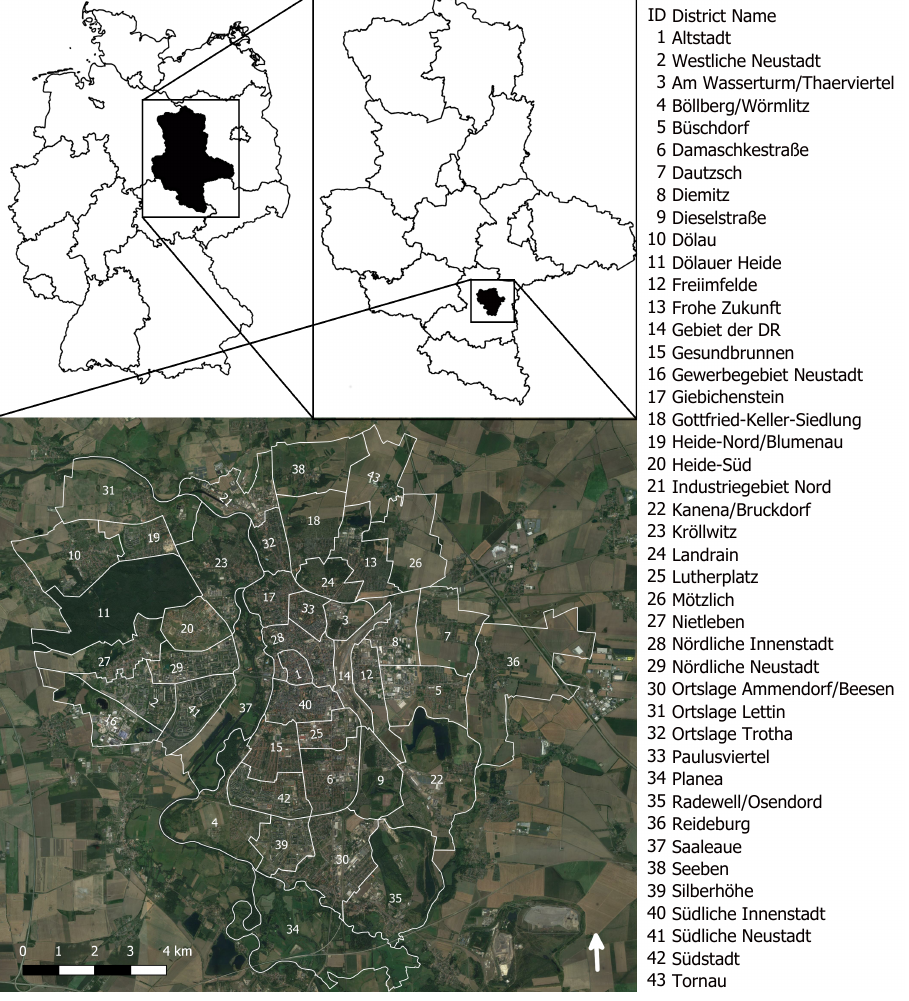
Figure 1. Map of the city of Halle with district names (in the geographical information system software QGIS, version 2.18; Google Maps 2018; German Federal Agency for Cartography and Geodesy—BKG 2018 [27]). Halle is located in the Federal State Saxony–Anhalt ( top right ) of Germany ( top left ). The Saale–Elster meadow and Saale–Elster floodplain are mainly located in the districts Saaleaue, Böllberg, Kröllwitz, Trotha and